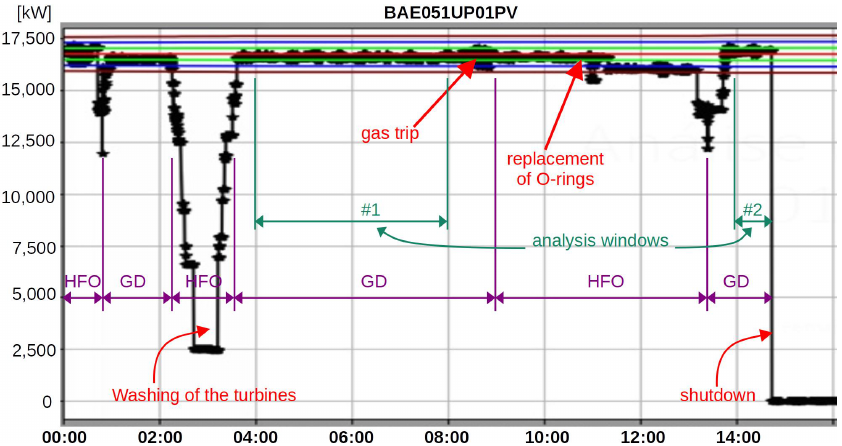
Figure 7. Control chart of active power of generation unit 05—on the day of the shutdown event.